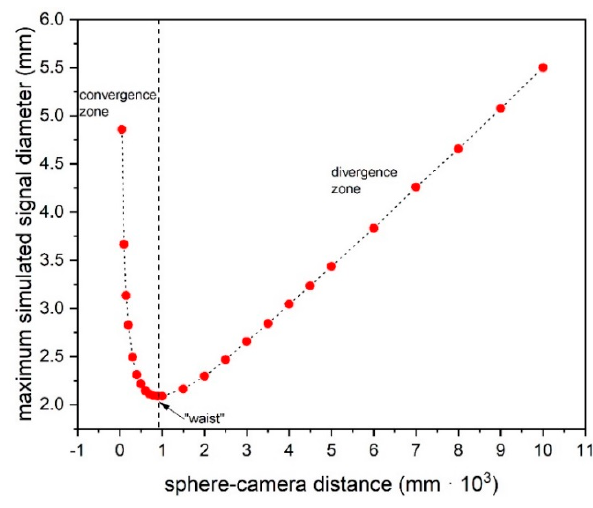
Figure 20. Size of the surrounding ring at different distances to the sphere.